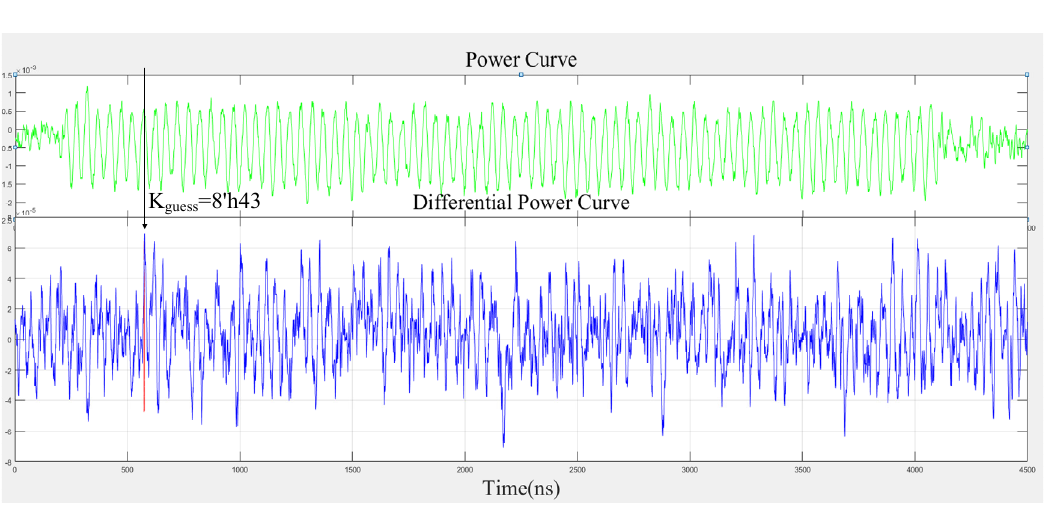
Figure 8. DPA curve of the low 8-bit output of the second round of transformation byte replacement Figure8. DPAcurveofthelow8-bitoutputofthesecondroundoftransformationbytereplacementoperation. operation.